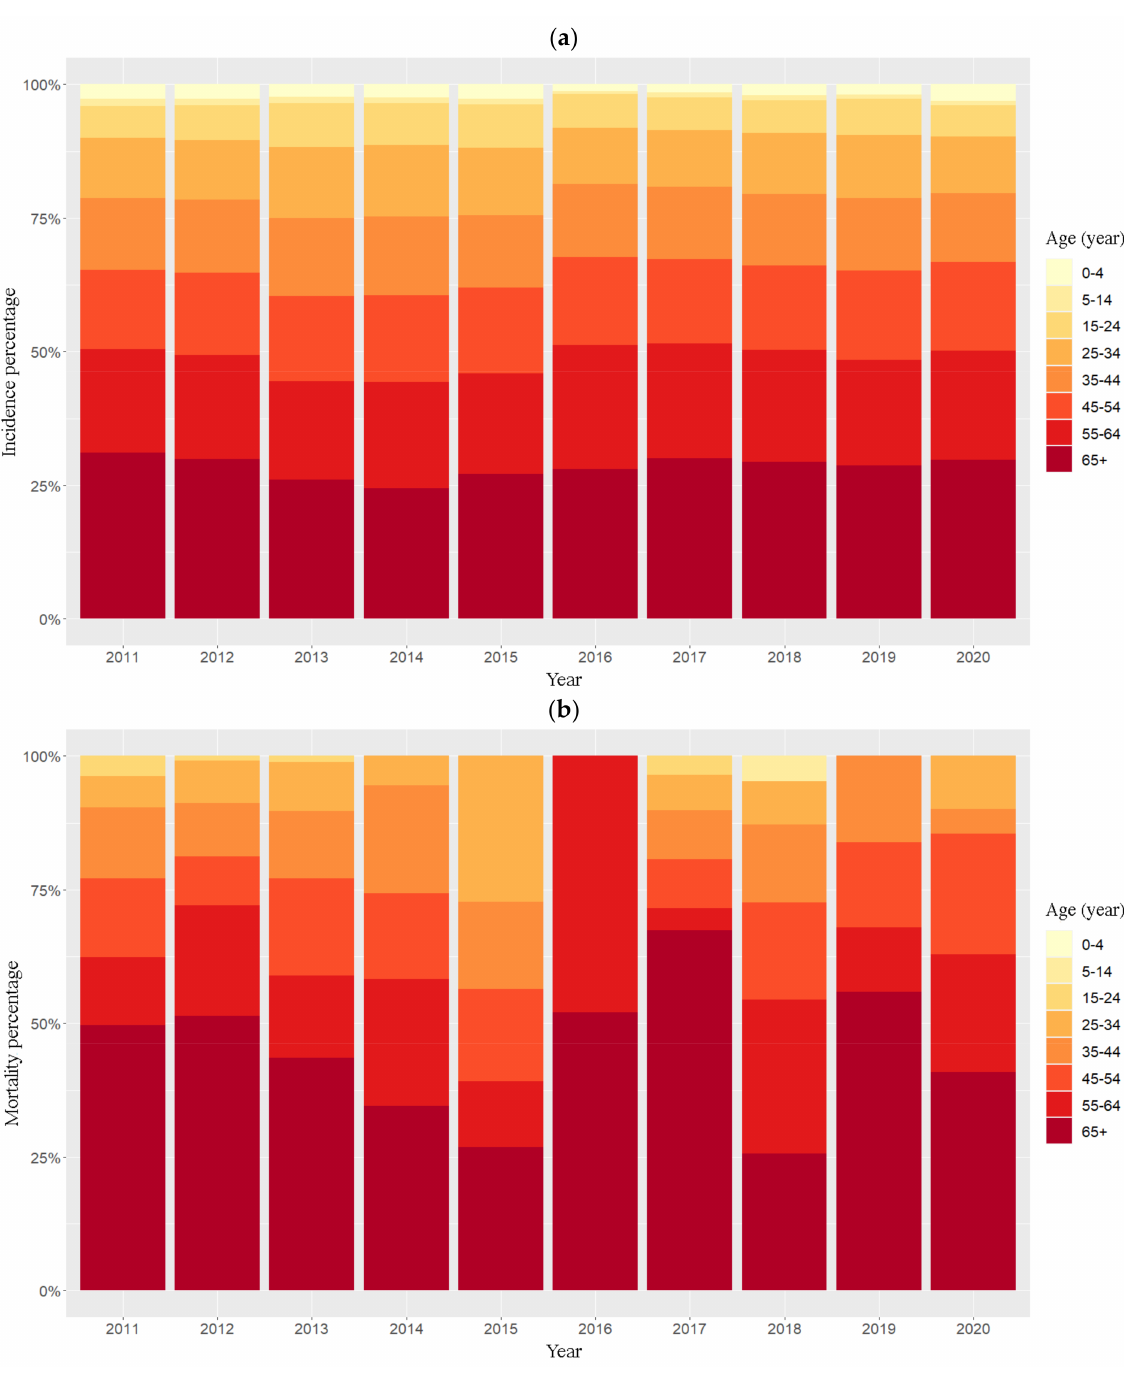
Figure 2. Annual proportion of standardized incidence ( a ) and mortality ( b ) by age group